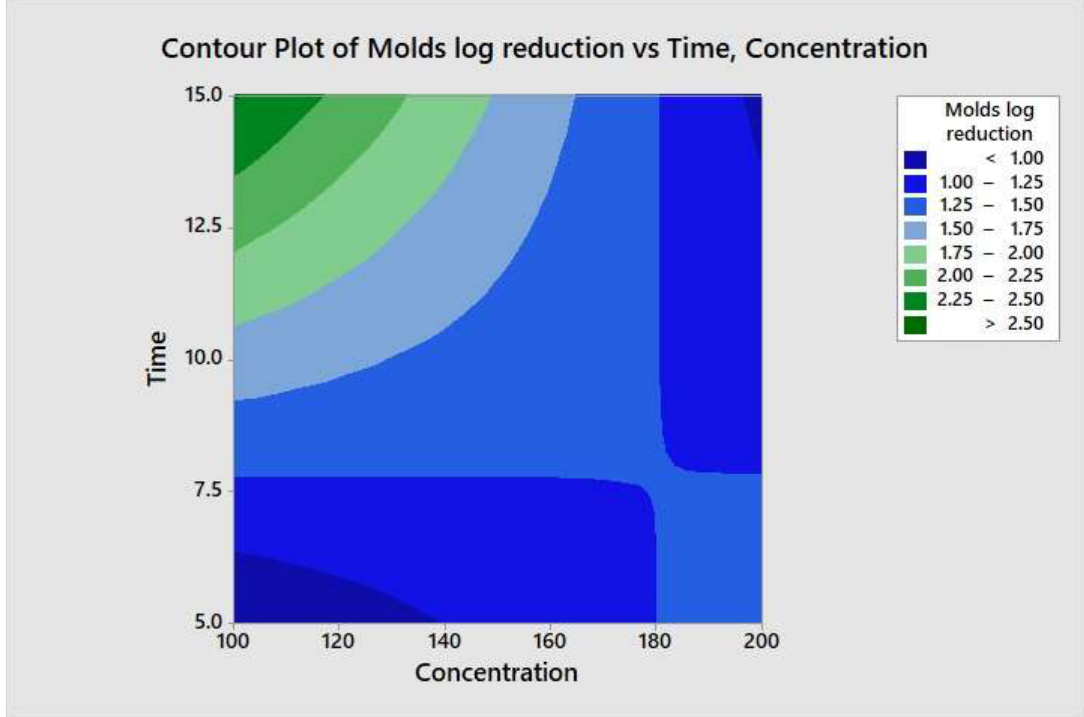
Figure 10. Contour plot of the molds logs reduction versus time and concentration.